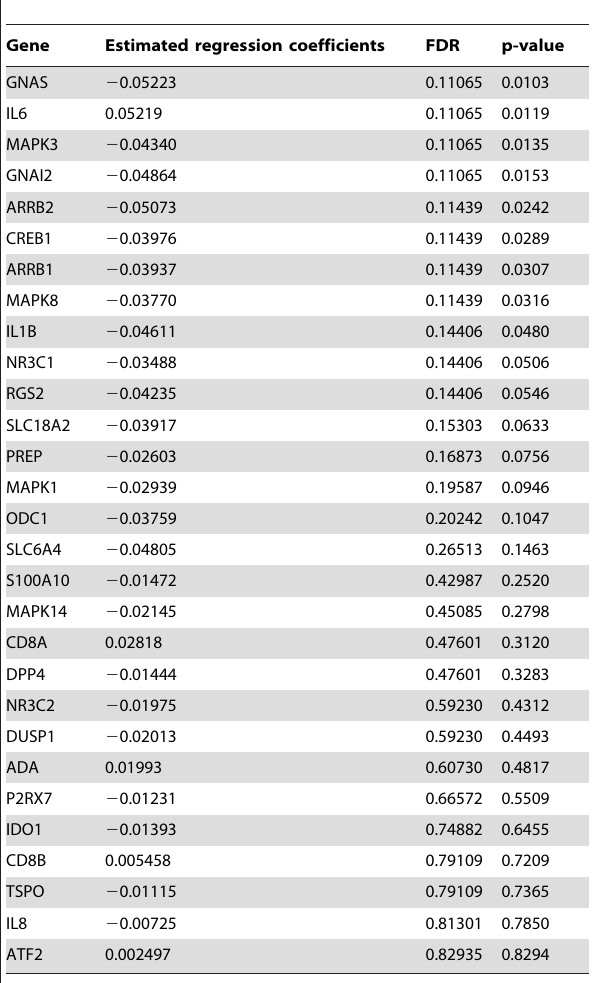
Table 1. Gene expression level associated with DSS total score sorted by